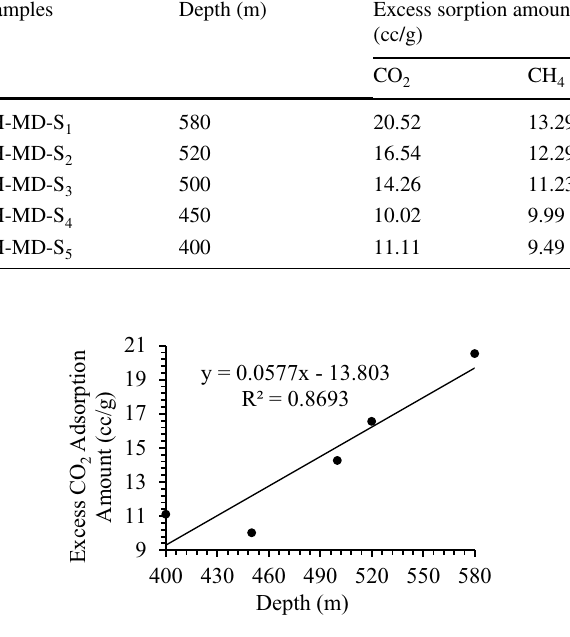
Fig. 4 Variation of excess CO